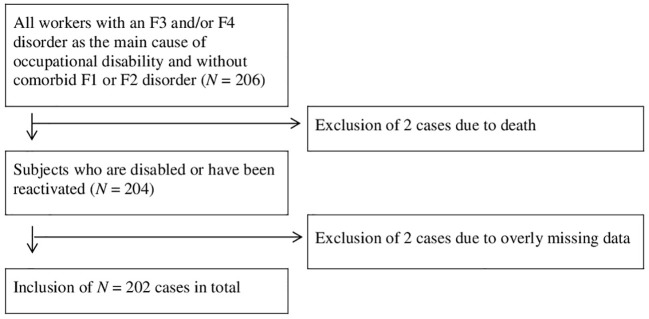
Sampling strategy.